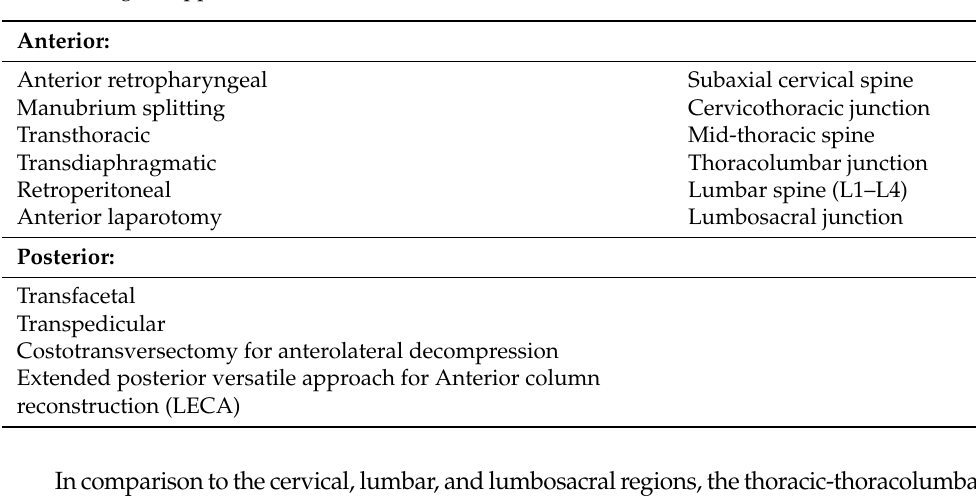
Table 2. Surgical